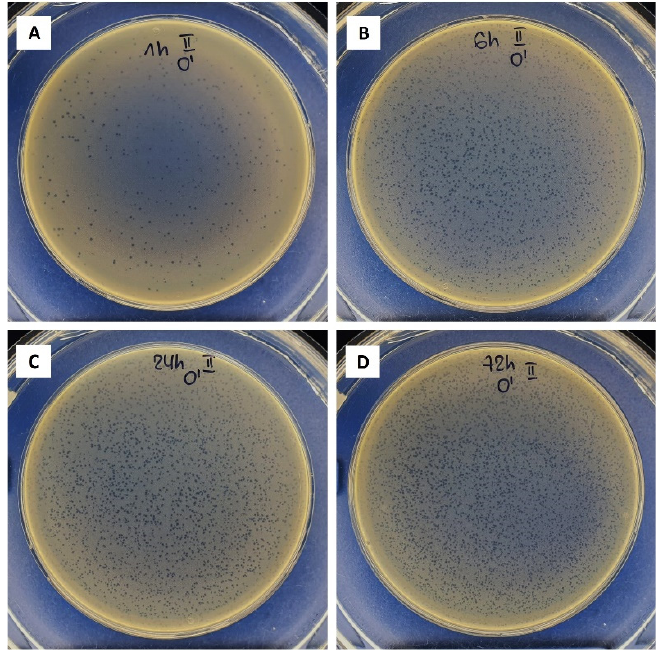
Figure 6. Plaques formed by the Pyo bacteriophages released from Ca-alginate hydrogel in the TRIS-HCl buffer after incubation for ( A )—1 h, ( B )—6 h, ( C )—24 h, and ( D )—72 h (no dilution).